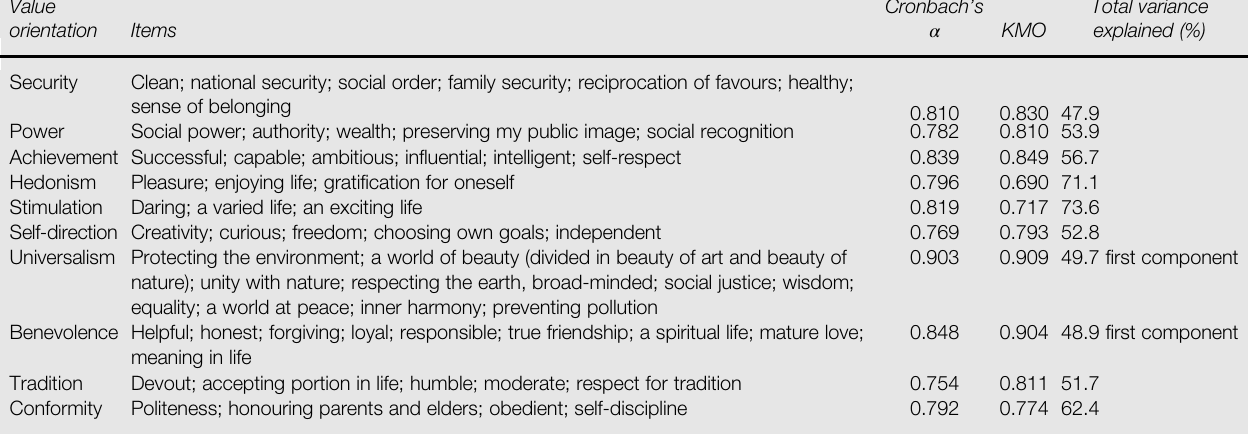
Table II Value orientations (Schwartz, 1994) processed from sampled